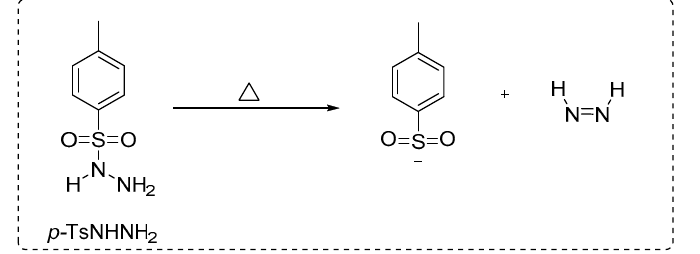
Figure 7. Methodology for the synthesis of chlorin via the hydrogenation of a porphyrin precursor by using p -TsNHNH 2 . Red circle: pyrrole ring; Blue circle: pyrrole ring reduced.